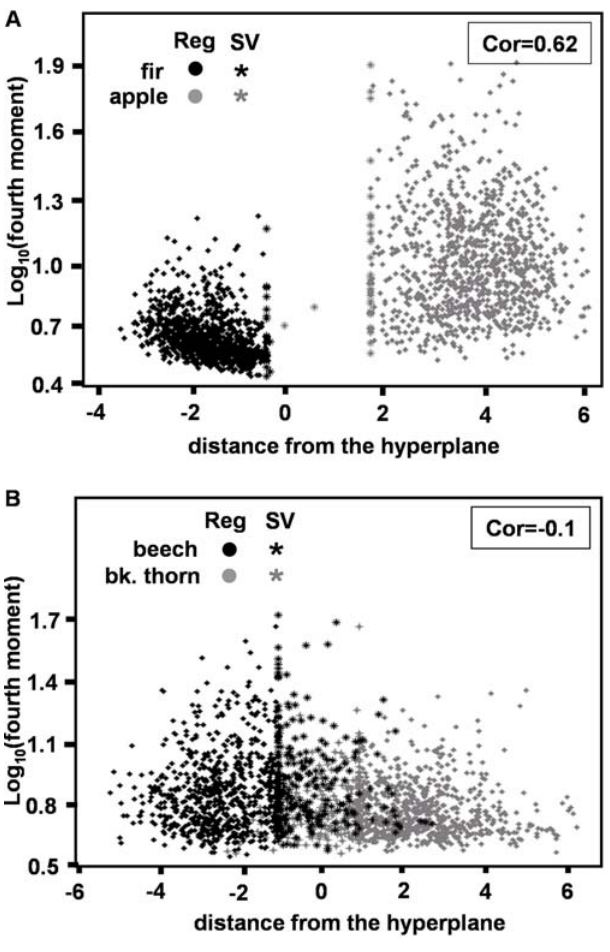
Figure 8. The correlation between the distance from the separating hyperplane and the fourth moment of the echoes. o – regular data point, * – support vectors. Correlation values are indicated in rectangles in upper right corner. (A) The comparison for the task of classifying apple and spruce reveals a high correlation between the distance and the fourth moment. (B) The comparison for the task of classifying beech and blackthorn reveals no correlation between the distance and the fourth moment, implying that the fourth moment cannot be used to classify the two. This figure also visualizes how the task in (A) is easy for the SVM compared to the one